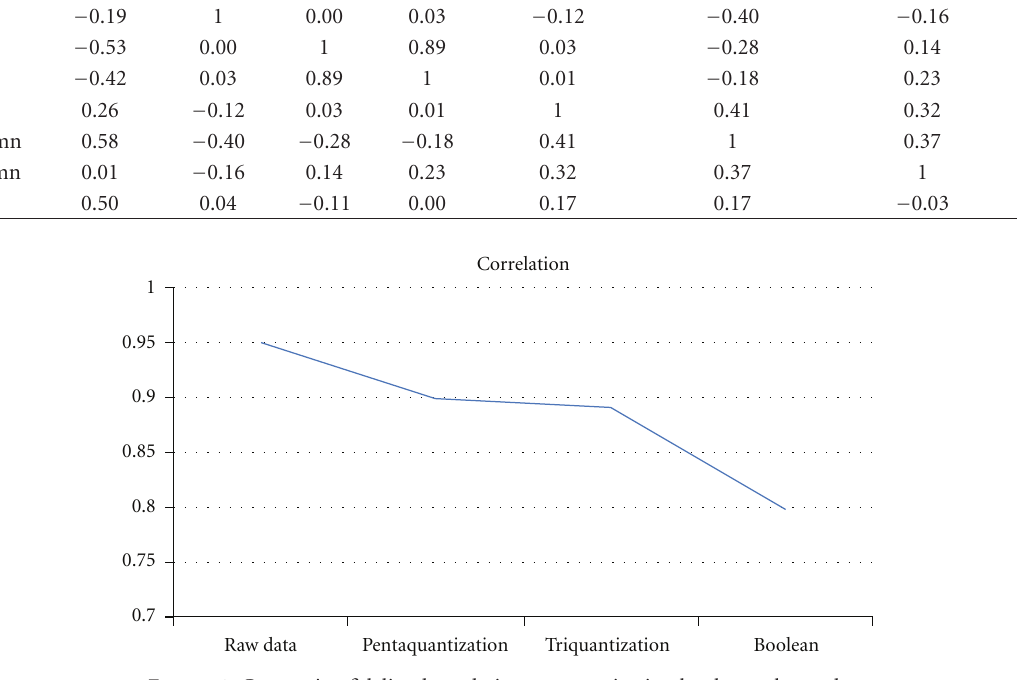
Figure 1: Comparing fidelity degradations as quantization levels are changed.